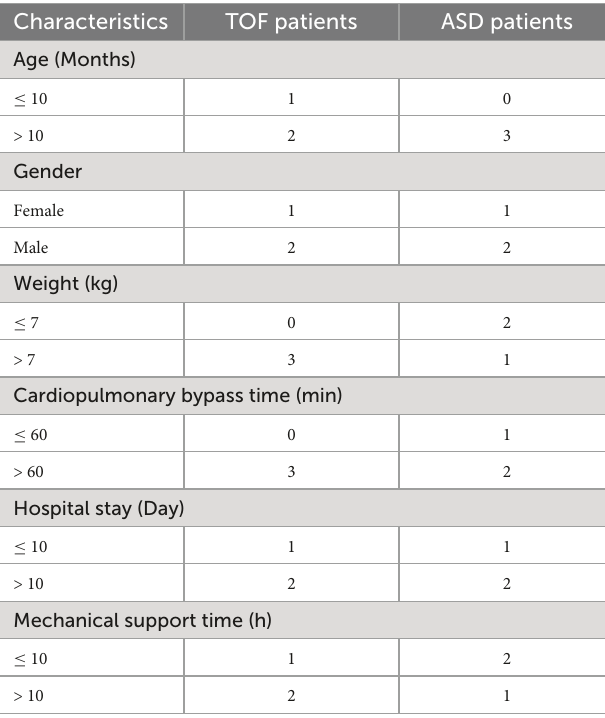
TABLE 1 Clinical characteristics of